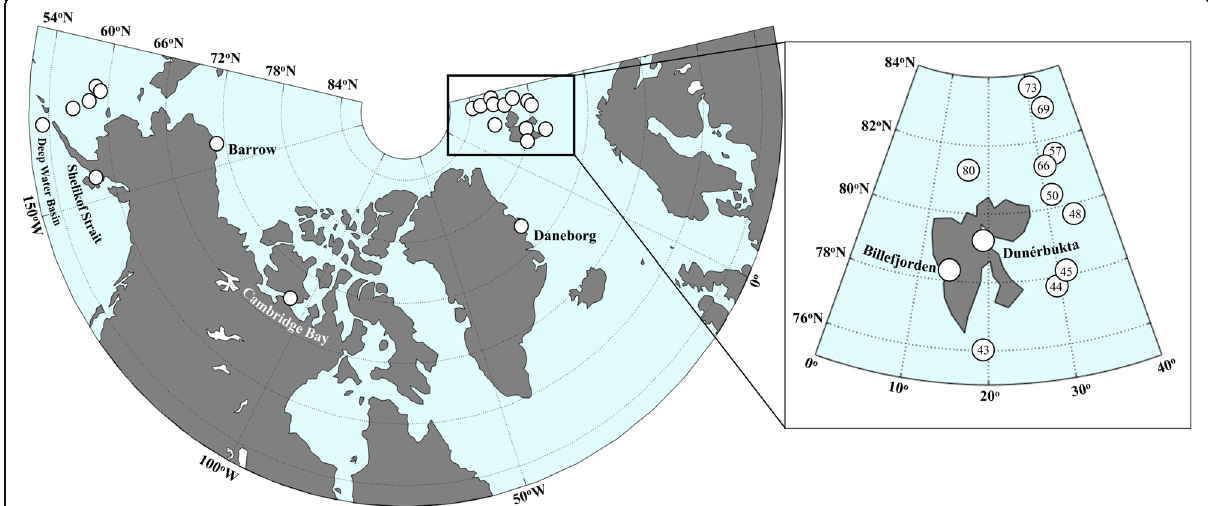
Fig. 1 Sampling sites of sea ice, seawater, and sediment across the Arctic, including the Bering Sea, Greenland and Svalbard. Note that Barrow, Alaska has been sampled several times (see Table